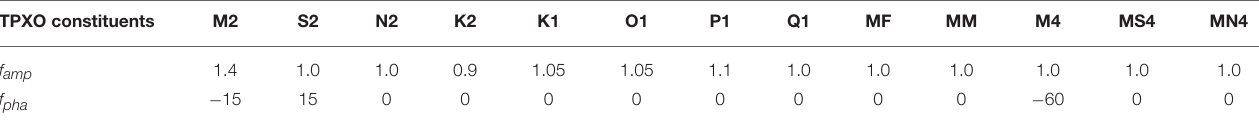
TABLE 3 | Factors f amp and addends f pha used to correct the Gulf Model input amplitudes and phases. TPXO constituents M2